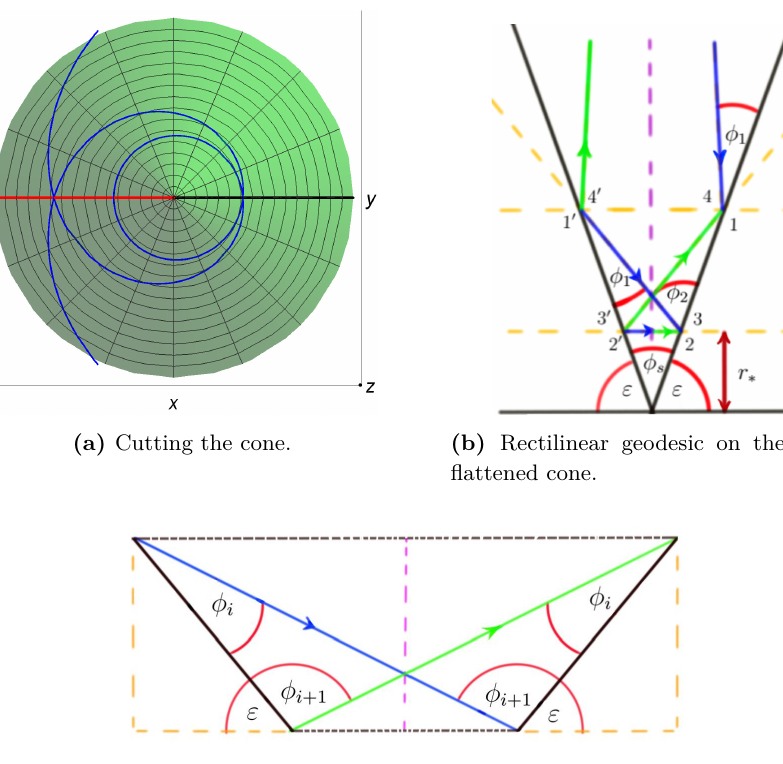
Figure 2. Rectilinear geodesic motion in the cone. Figure 2a: to construct the flattened cone, we cut it along the straight line (shown in black), which is opposite (with respect to the cone symmetry axis) to the straight line (shown in red) going from the cone’s vertex to the point of perihelion. As a result we obtain a flattened sector of the angle ϕ = 2 π , with identified edges. Figure 2b: the s α rectilinear character of geodesic in the obtained angular sector with identified edges. The incoming part of the trajectory (from infinity to the point of perihelion r ) is represented in blue, while the ∗ outgoing part (from r to infinity) is shown in green. When the particle arrives at the right edge in ∗ a point i at an angle of incidence φ , it emerges from the left edge in the point i 0 at the same angle, i and continues its rectilinear path to the point ( i + 1) , and so on. In the general case the particle “hits” the edges several times. Note that by the construction, the lowest triangle on the diagram, appearing when α > 2 , with the vertex corresponding to the cone’s vertex and opposite side going through the perihelion r , is always isosceles. This implies that the last angle of incidence equals ∗ (cid:0) 1 (cid:1) . Figure 2c: the shown geometric structure appears several times in accordance with ε = π − 1 2 α the number of nonzero incidence angles. Using the geometric properties of the triangles, one has that φ = φ 2 ε + π , and making use of the fact that the last angle corresponds to ε , we obtain i +1 i − (cid:0) 1 (cid:1) where φ n − ‘ = π − 2 ‘ +1 n represents the number of incidence angles (the number of “reflections” 2 α at the edges for α > 2 ) and ‘ = 0 , 1 , . . . , n − 1 . From the condition φ 0 we get that 2(2 n − 1) < α 1 >